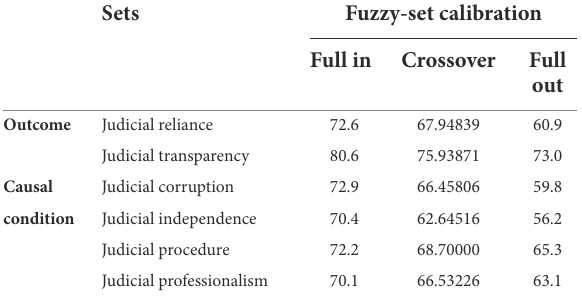
TABLE 2 Calibration of causal conditions and outcome.